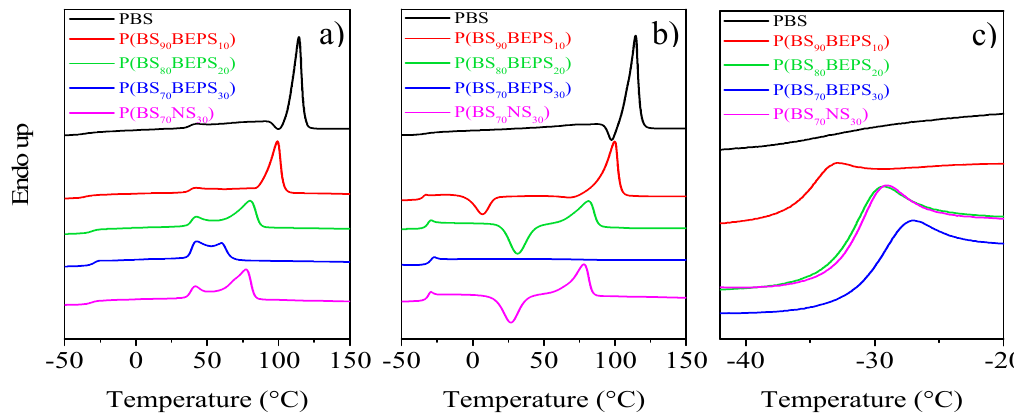
Figure 4. Calorimetric curves (heating rate: 20 °C/min) of PBS, P(BS m BEPS n ) and P(BS 70 BEPS 30 )